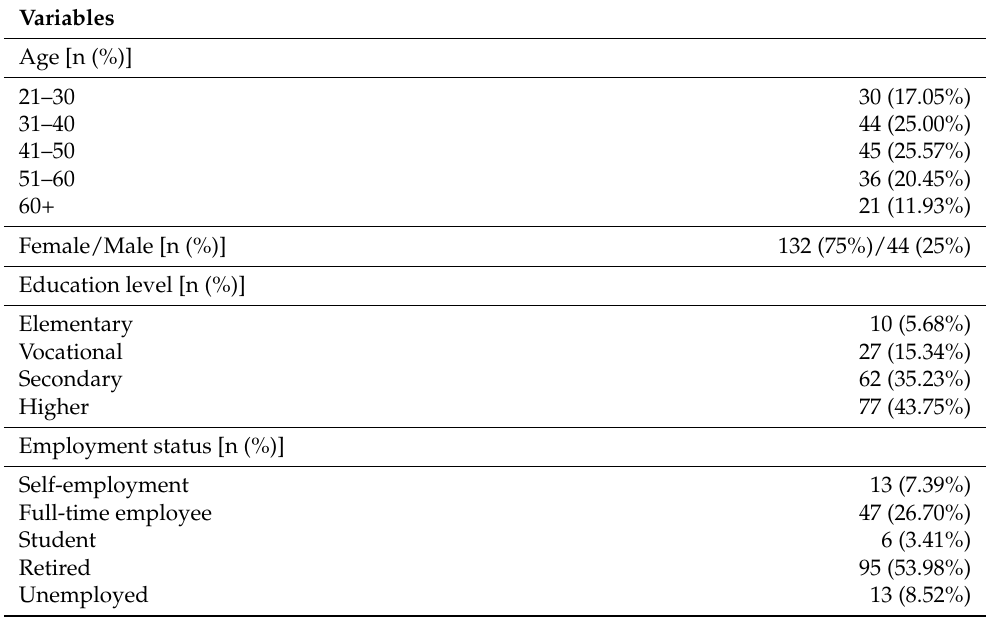
Table 1. Demographics and disease characteristics of the MS study